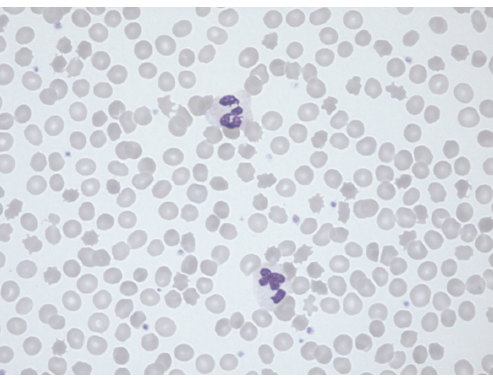
Figure 1: Peripheral blood smear demonstrating the typical appear- ance of spiked erythrocytes,